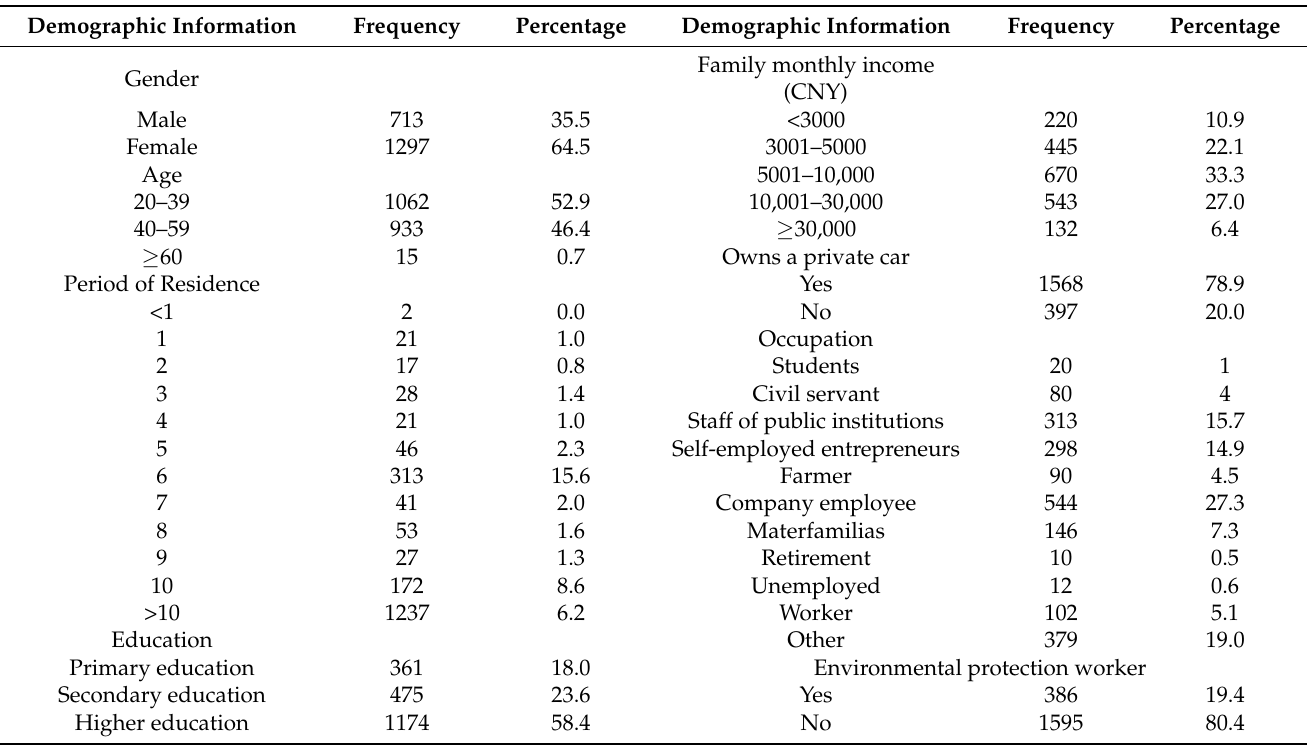
Table A2. Demographic information for the valid questionnaires ( n =